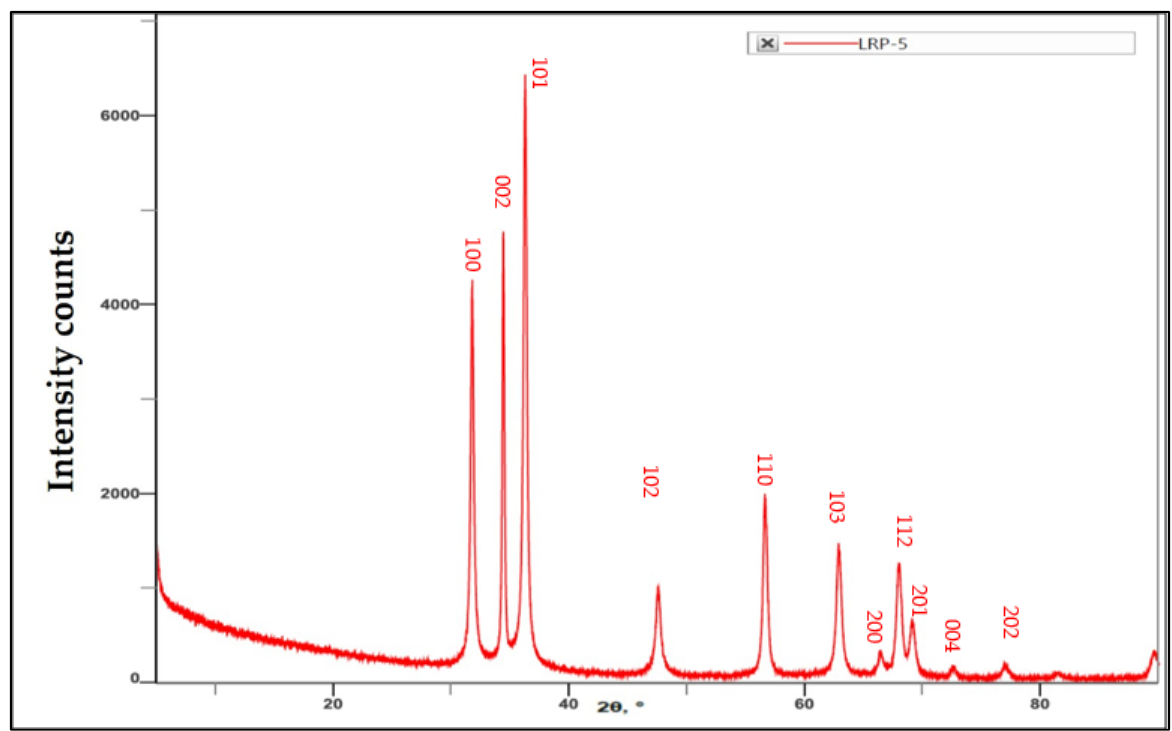
11 of 19 Table 3. EDS result of ZnONPs of leaf extracts of R. sativus showing fitting ratio. Display Name